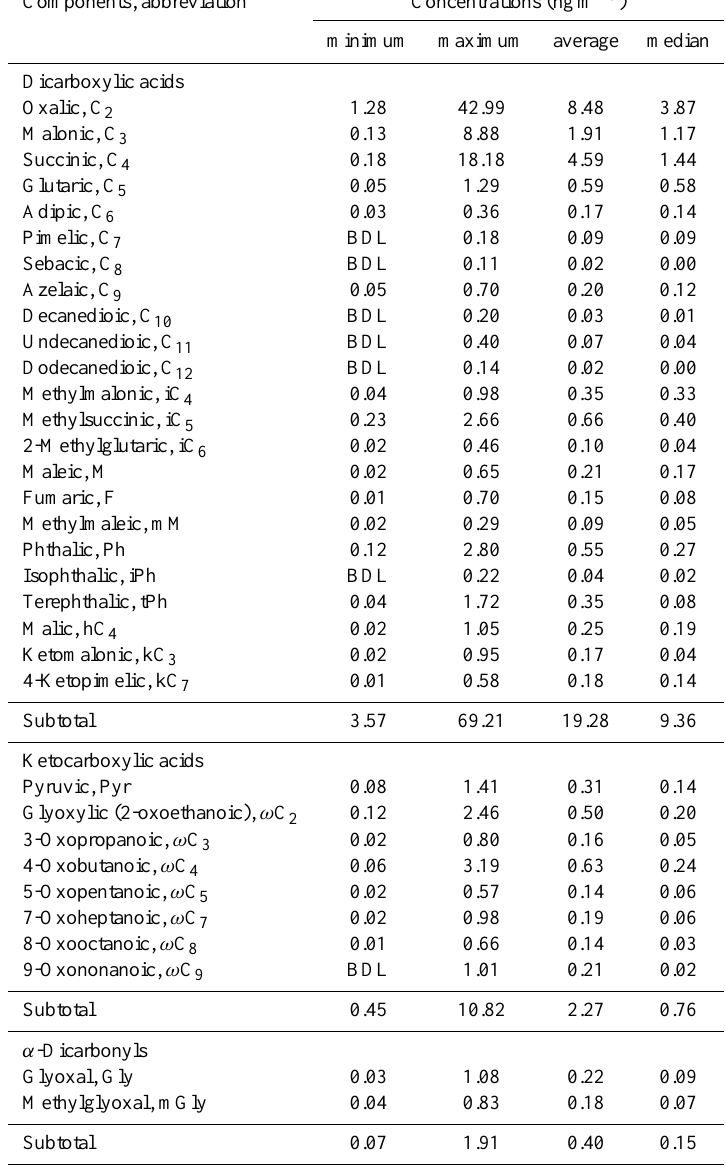
Table 1. Concentrations of dicarboxylic acids, ketocarboxylic acids and α -dicarbonyls in the marine aerosols collected over the western Arctic Ocean during MALINA cruise in August